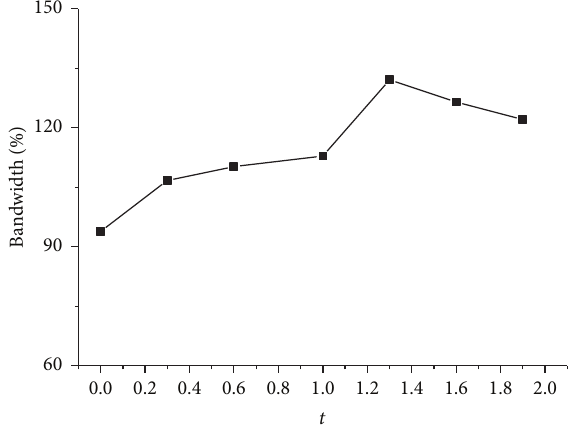
Figure 6: Simulated bandwidths of various 𝑡 values.